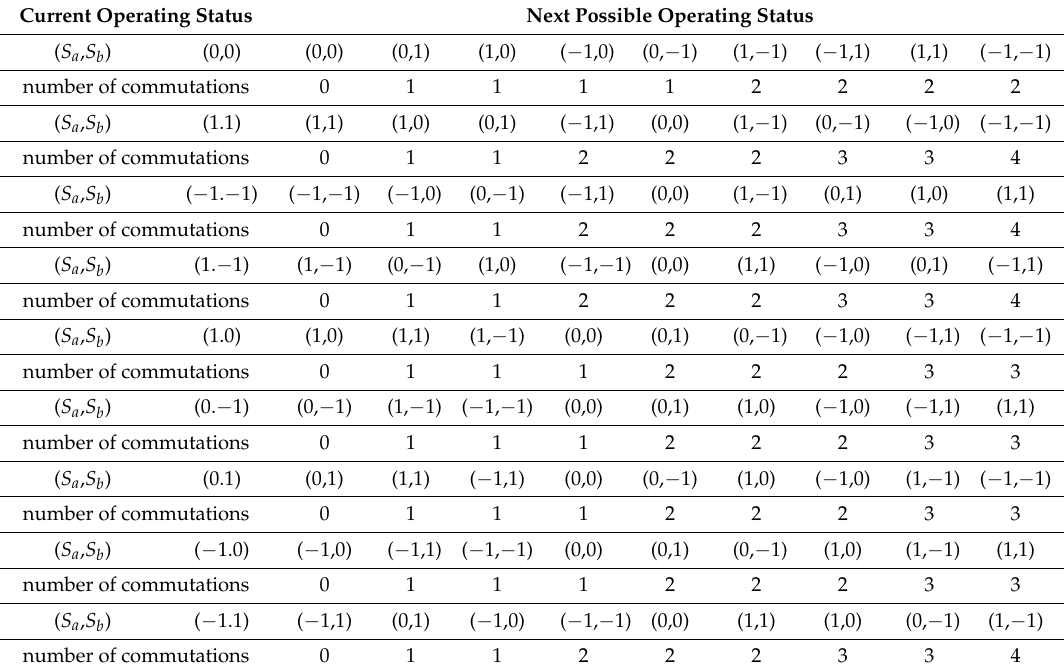
Table 2. Number of commutations involved in switch transitions from current step to next step in conventional MPC